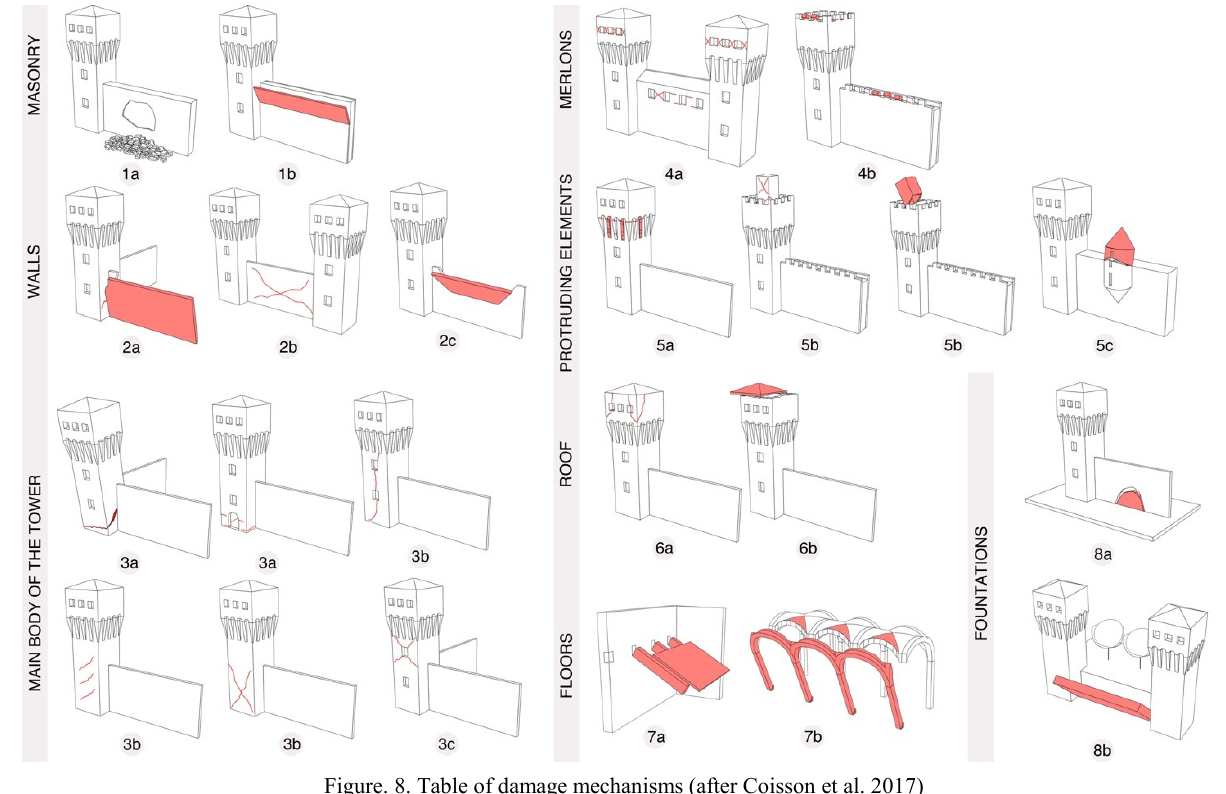
Figure. 8. Table of damage mechanisms (after Coisson et al. 2017)